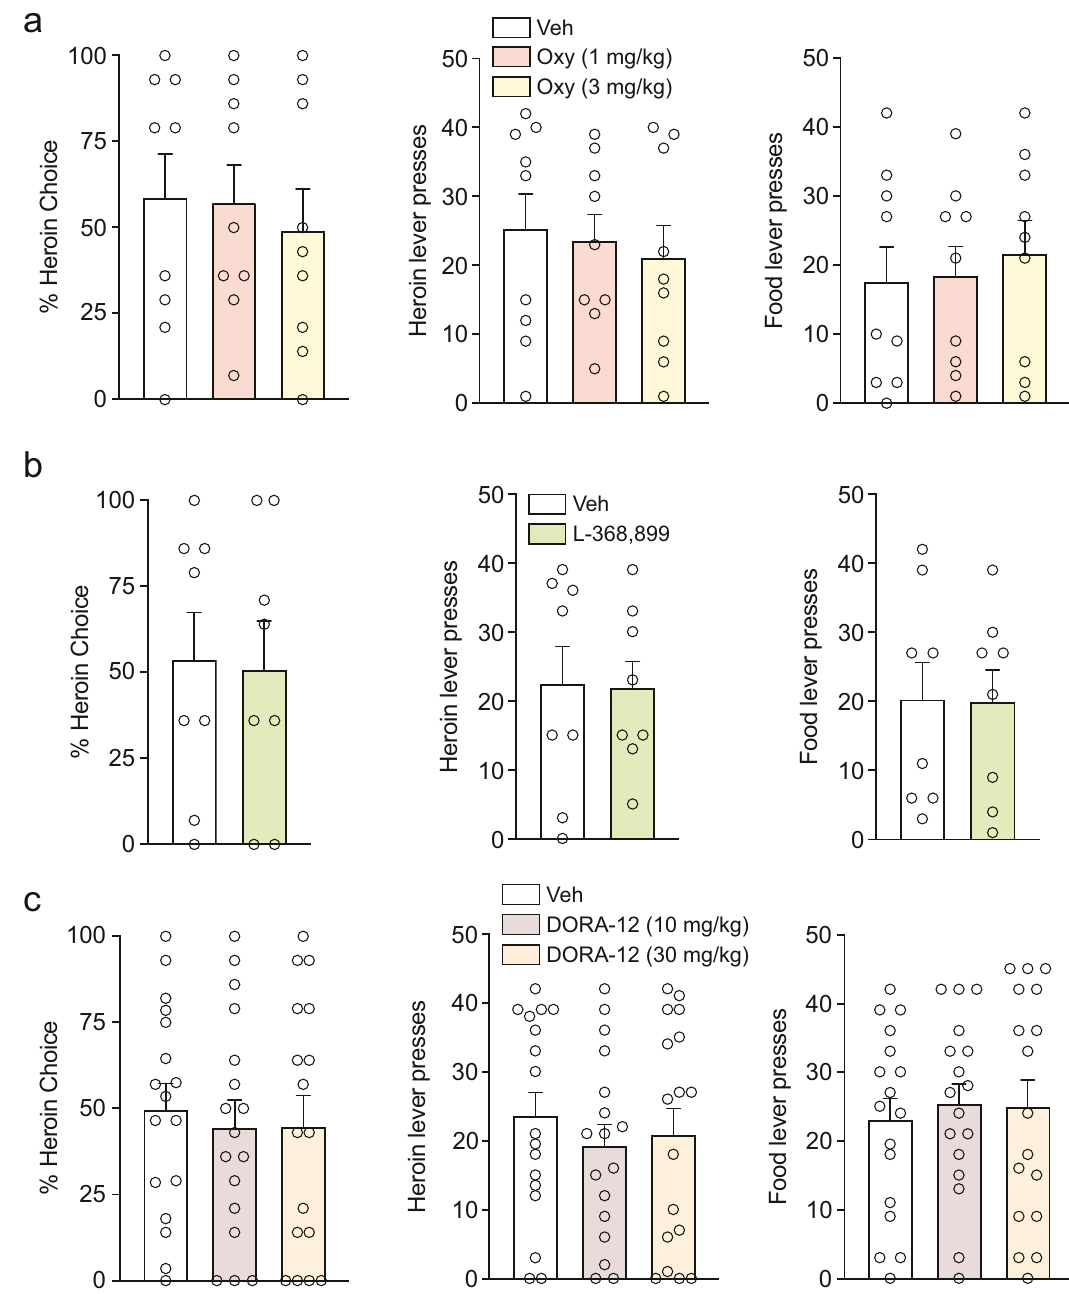
Fig. 3 Oxytocin and orexin agents do not alter heroin choice. Neither the low dose (1 mg/kg) or the high dose (3 mg/kg) of oxytocin altered heroin choice ( a , left), or lever presses for heroin ( a , middle) or food ( a , right). The oxytocin antagonist, L-368,899 (5 mg/kg), did not alter choice ( b , left), lever presses for heroin ( b , middle) or food ( b , right). The dual orexin receptor antagonist DORA-12 did not alter heroin choice ( c , left), lever presses for heroin ( c , middle) or food ( c , right), at either the low (10 mg/kg) or high dose (30 mg/kg). Data shown as mean ±